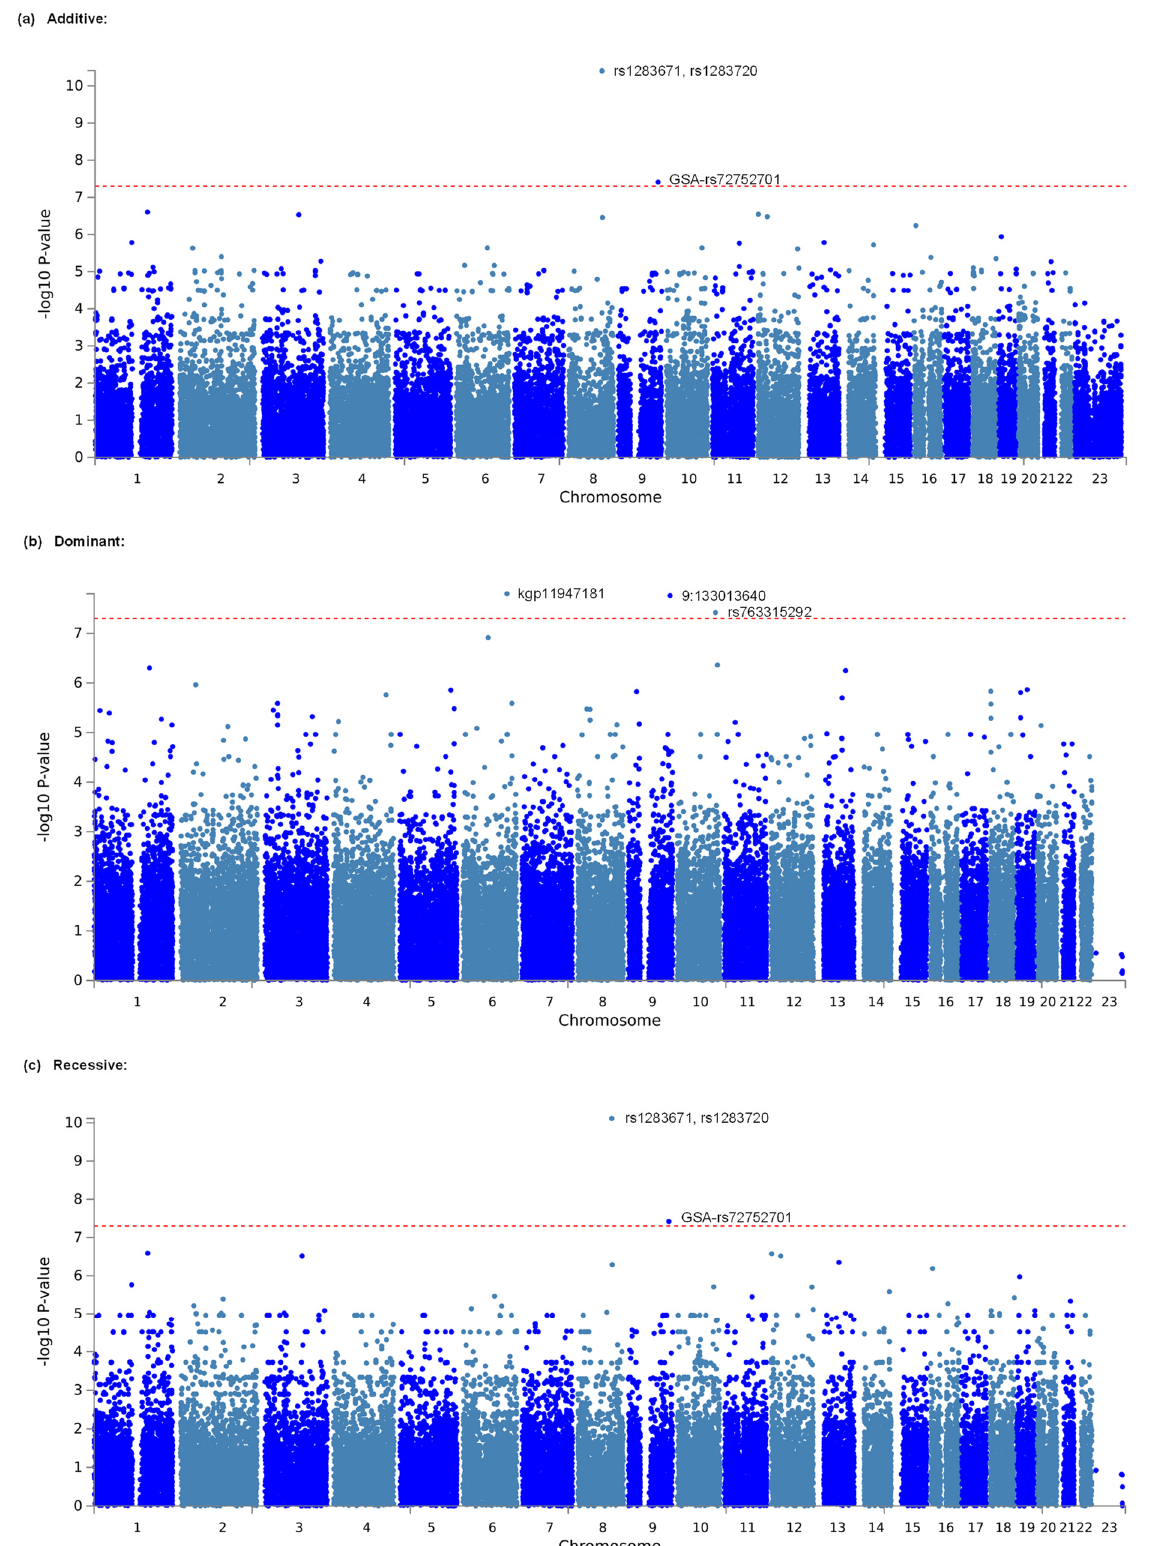
Figure 1. Manhattan plot of GWAS outcomes. ( a ) Analytical plot in the additive model. ( b ) Analytical plot in the dominant model. ( c ) Analytical plot in the recessive model. The dashed red line shows the significant association threshold.